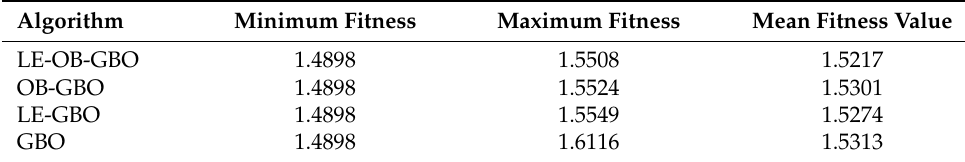
Table 10. Statistical analysis for charging station placement—case 3.